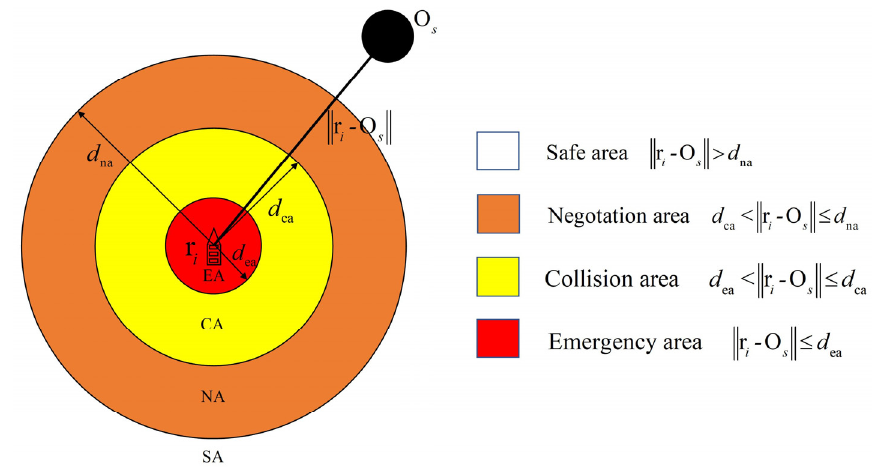
Figure 10. Types of collision-avoidance actions with the distance between obstacles and MASS (unmanned ship).